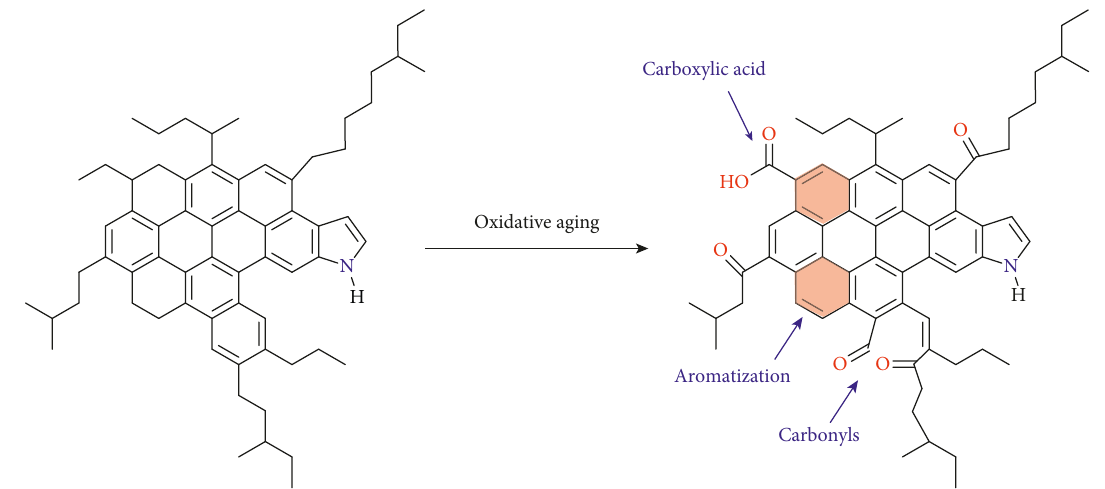
Figure 5: Molecular structures of asphaltene-pyrrole before and after